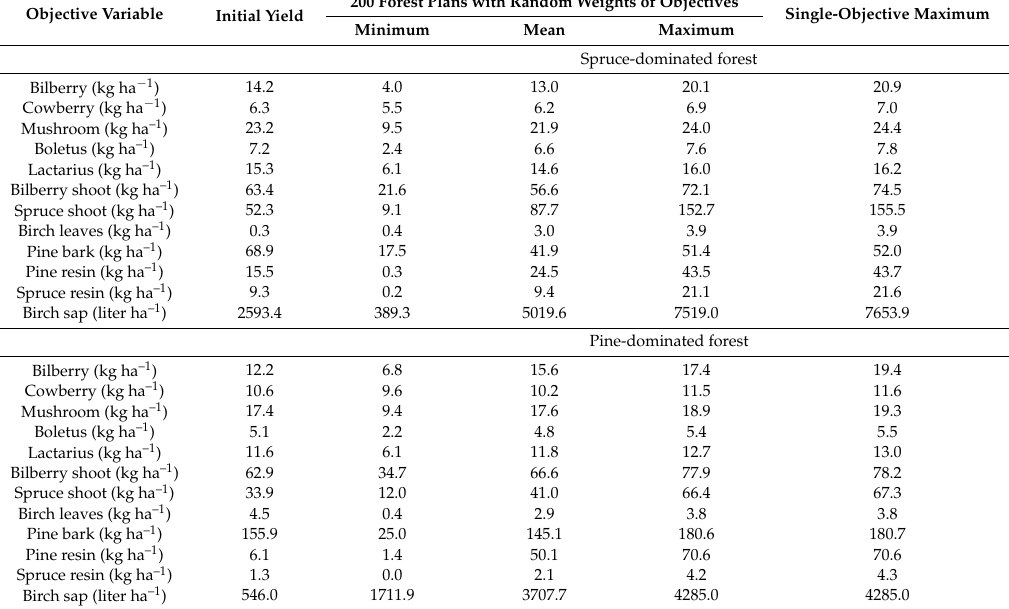
Table 2. Initial yield and minimum, mean, and maximum yields of non-wood forest products at the end of the 30-year period obtained by following a total of 200 holding-level forest plans in which the weights of the objective variables were assigned randomly, or by setting only a single